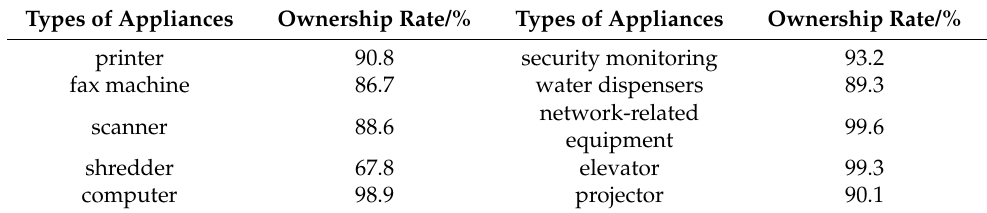
Figure 9. Probability of using different appliances at different times.